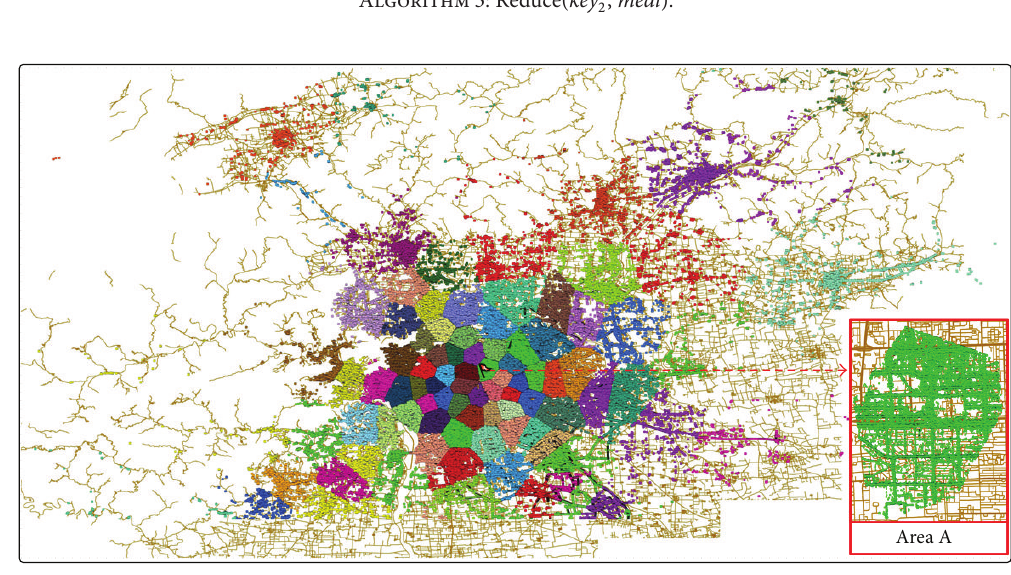
Figure 8: Clustering results of large-scale taxi